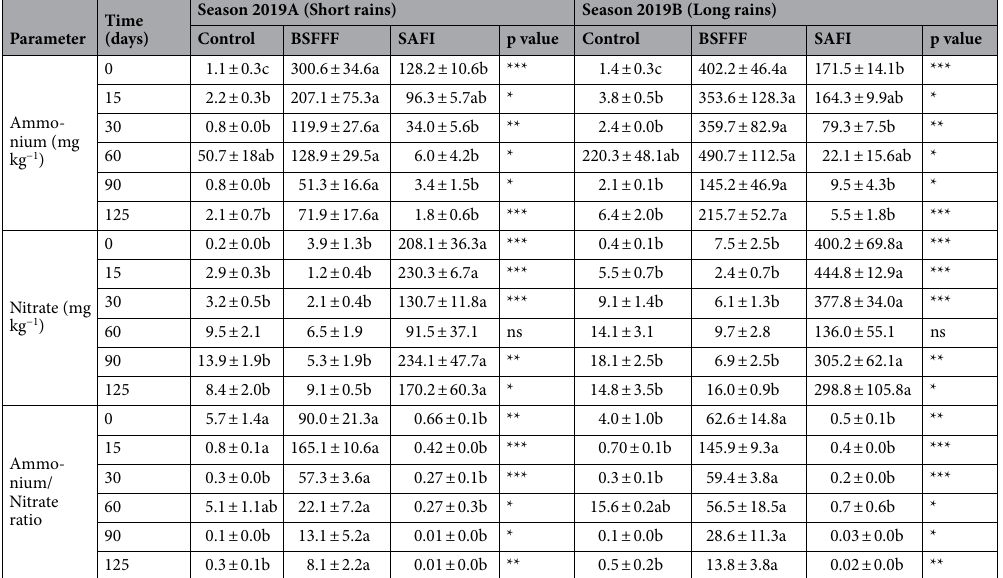
Table 1. Concentrations of ammonium and nitrates, and ammonium-nitrate ratio of soil amended with BSF frass and commercial organic fertilizers. *** p < 0.001, **p < 0.01, *p < 0.05, ns = not significant at p ≥ 0.05, BSFFF = Black soldier fly frass fertilizer, SAFI = commercial organic fertilizer, control = unamended soil. Within the same row and per parameter, means (± standard error) with the same letters are not significantly different at p ≥ 0.05, n =